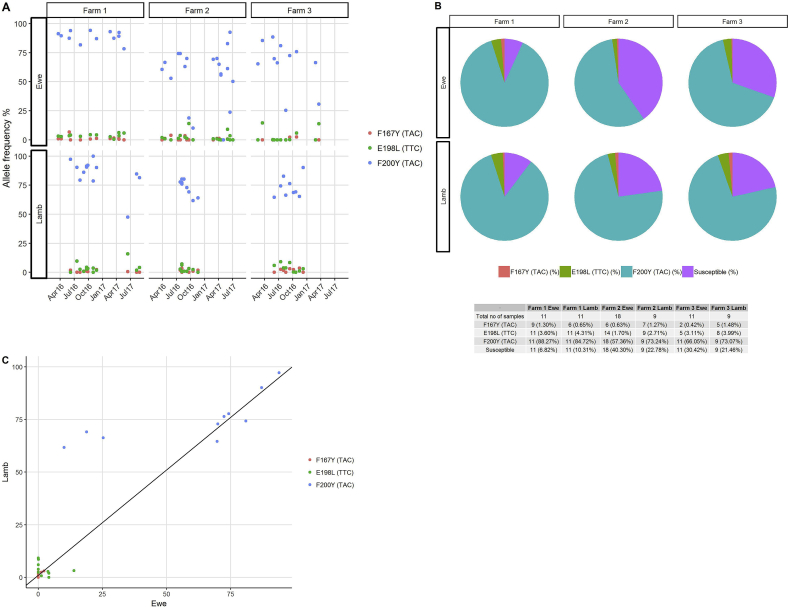
Allele frequencies of isotype 1 β-tubulin locus SNPs in field populations of T. circumcincta. Red colour indicates F167Y (TAC), green indicates E198L (TTA) and blue indicates F200Y (TAC) and purple indicates susceptible alleles. Fig. 4A: dots represent the resistance allele frequencies for each sampling time-point. The data shows the three farms with date of sample collection on the X-axis and the Y-axis representing the allele frequencies. Fig. 4B: the pie charts show the overall prevalence of the isotype 1 β-tubulin locus SNPs in ewes and lambs on each farm. The prevalence of SNPs and combinations of SNPs at farm level are shown in the table below the figure. (For interpretation of the references to colour in this figure legend, the reader is referred to the Web version of this article.)